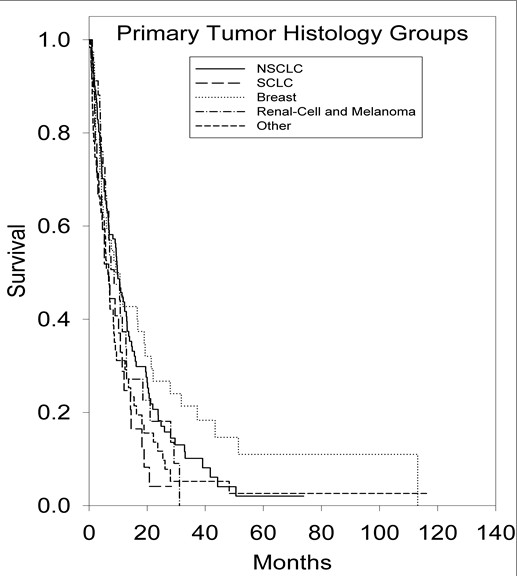
Kaplan-Meier survival curve illustrating overall survival based on primary tumor histology.